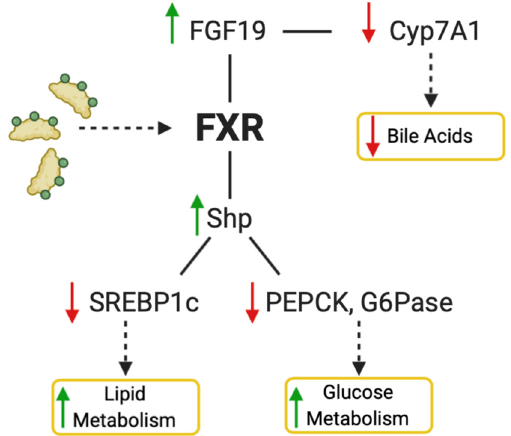
Figure 3. Activation of FXR by natural or synthetic ligands decreases bile acid production and increases lipid and glucose metabolism. For the bile acid pathway, FGF19 is upregulated and CYP7A1 downregulated, which in turn causes a decrease of bile acid synthesis. Activation of FXR also increases SHP, which decreases SREBP1c, PEPCK, and G6Pase, causing an increase in lipid metabolism and glucose metabolism. Figure created with BioRender (accessed on 7 February